Question: Express in one sentence what the figure is showing.
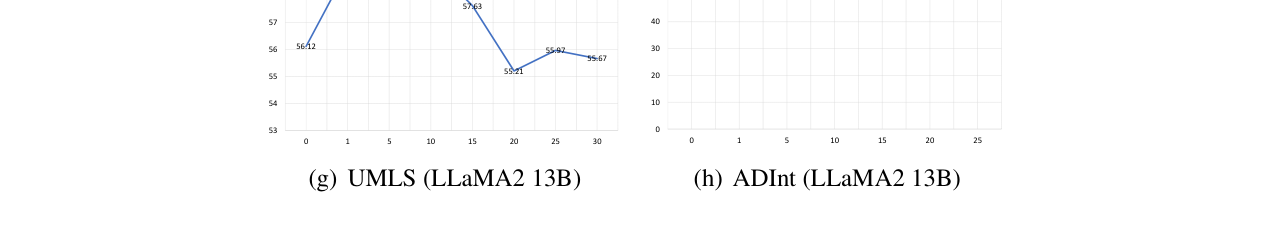
Answer: Different F1 (a-h)/Accuracy (i) performance of KNN-based retrieval model on 5 tasks over 9 datasets. We select the LLM with the highest baseline performance as our primary LLM model. The number of document samples depends on the input length constraint of the LLM. For instance, in dataset Mssample, when top−n > 2, the maximum input token length of 8318 exceeds the maximum input token length of 8192 tokens for GPT-4. y-axis: F1 (a-h)/Accuracy (i). x-axis: 0 represents no retriever, while 1-30 represents the top-n documents retrieved. The red font refers to the best performance.